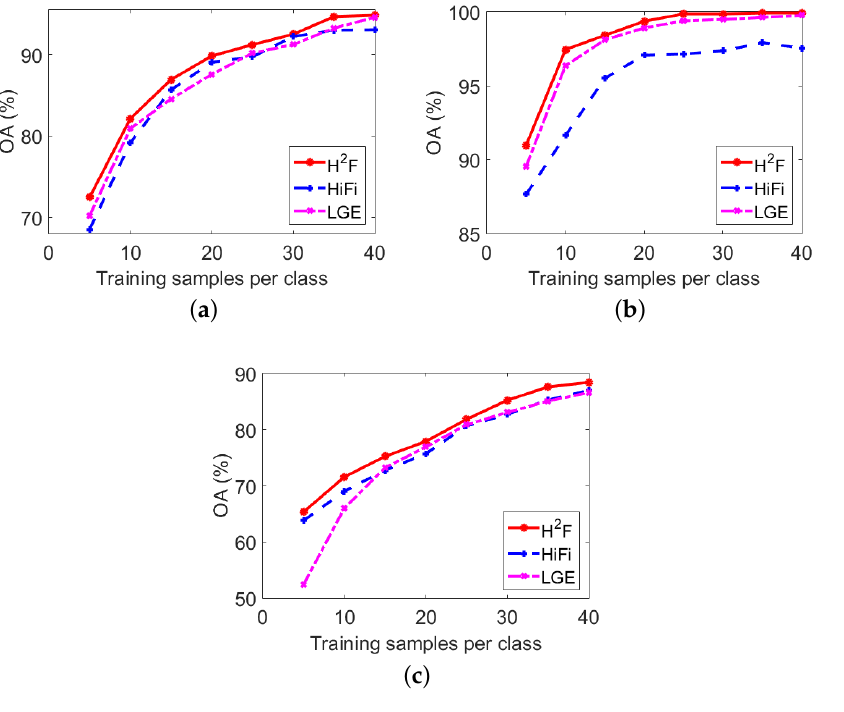
Figure 9. Influence of training samples number on ( a ) Indian Pines; ( b ) KSC and ( c ) GRSS_DFC_2014 data